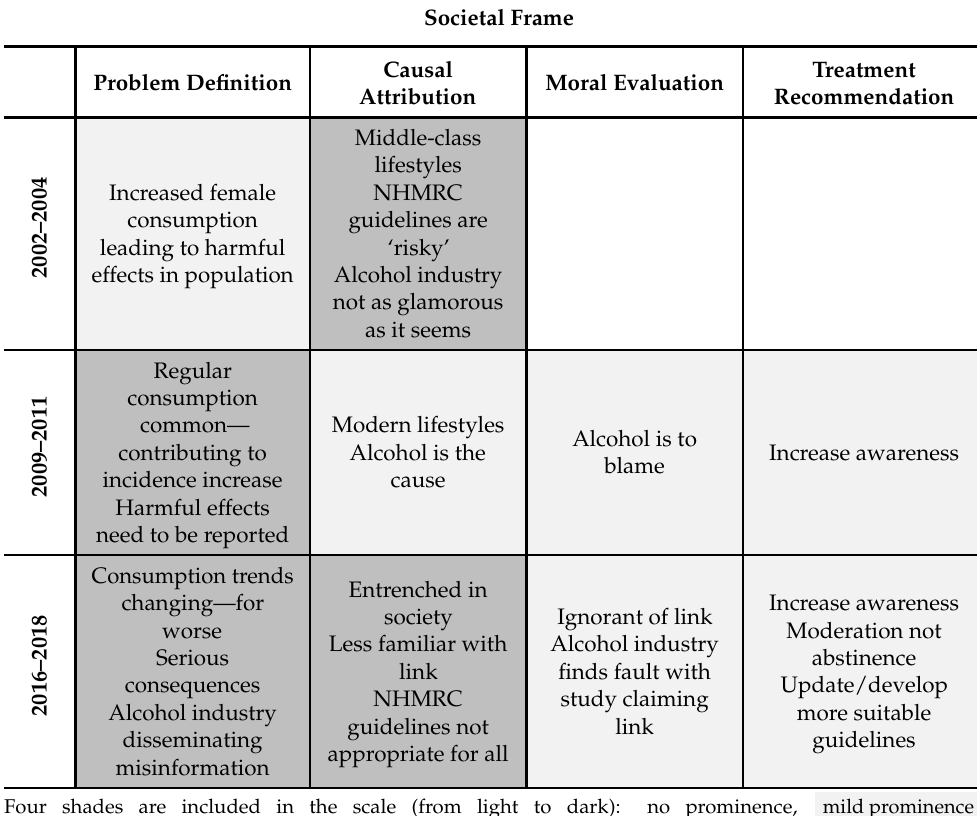
Table 3. Dominant societal frame